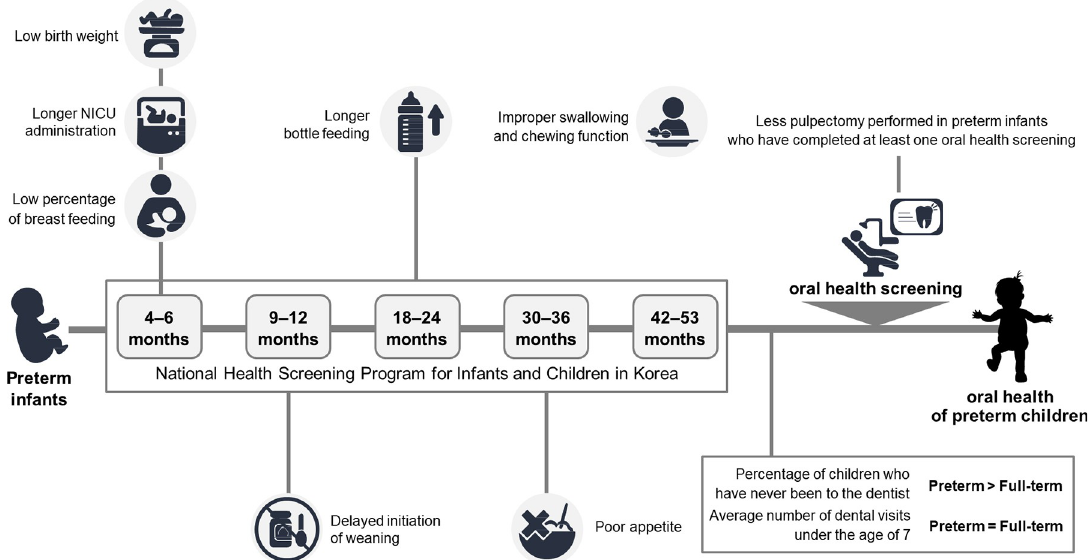
Fig 2. Summary of dietary habits, oral characteristics, and dental treatments in preterm infants in National Health Screening Program for Infants and Children in Korea, NICU; neonatal intensive care unit administration.